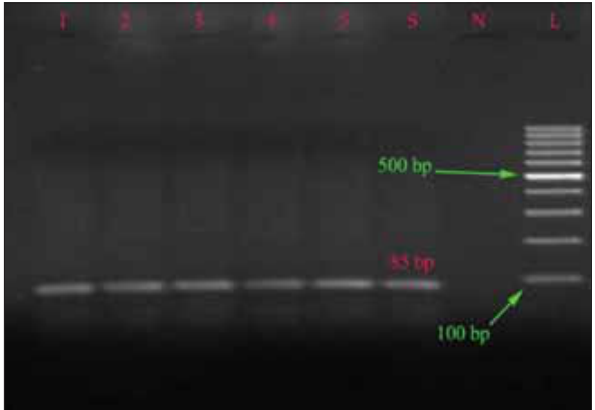
Figure-4: Agarose gel showing polymerase chain reaction amplification products of fim A gene (85